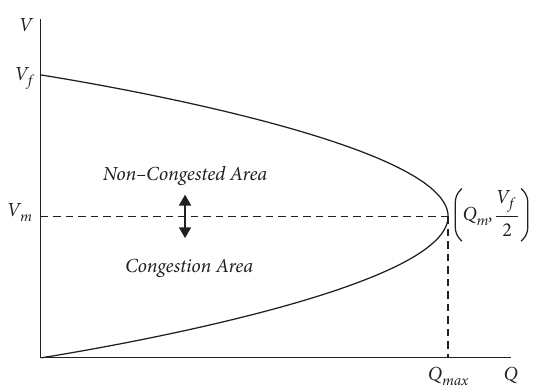
Figure 2: Traffic-velocity model congestion area division.